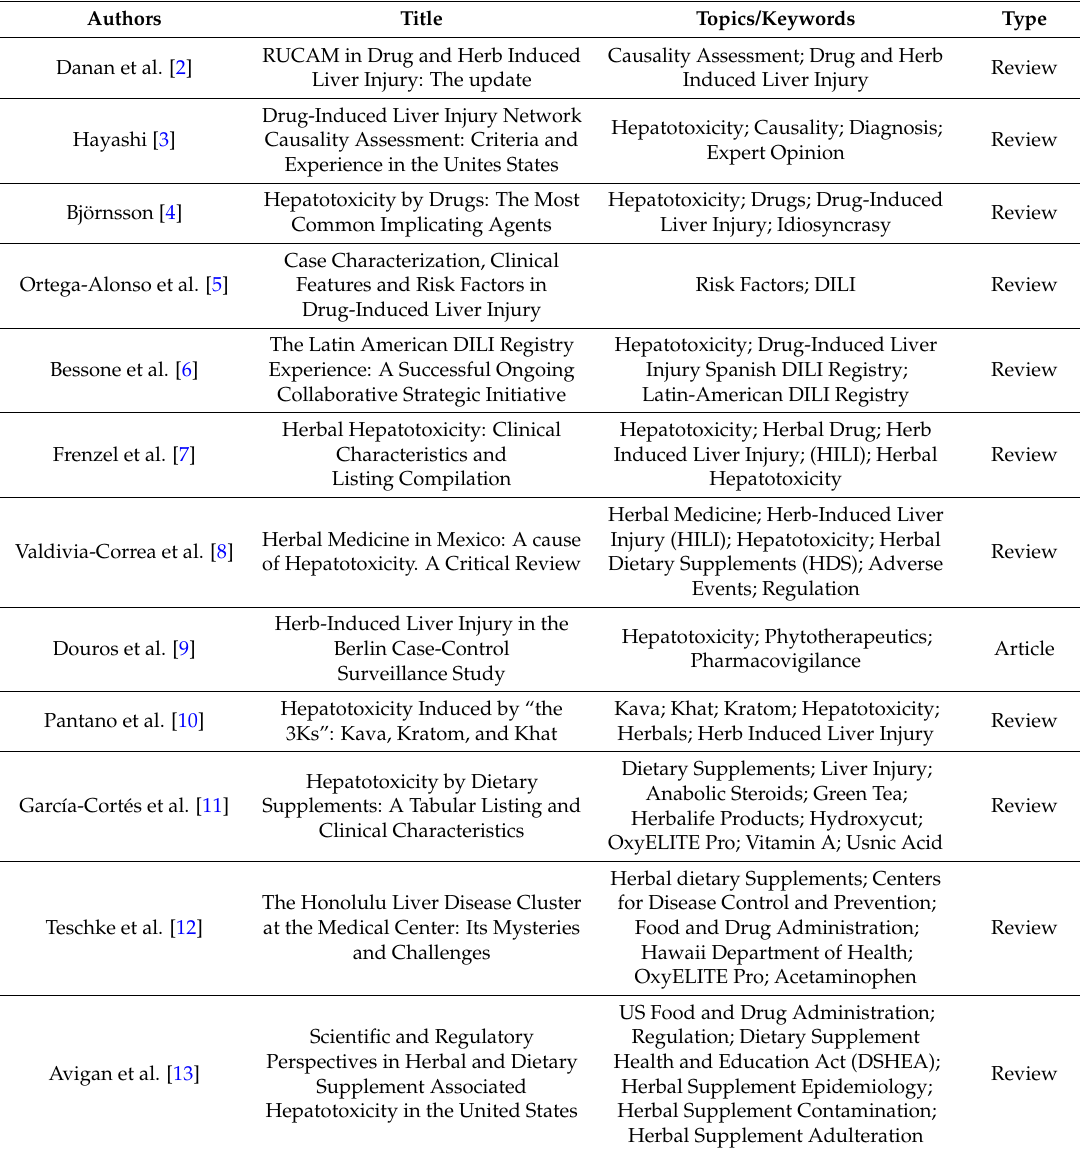
Table 1. Summary of papers in the Special Issue, arranged by topic as pertaining to liver